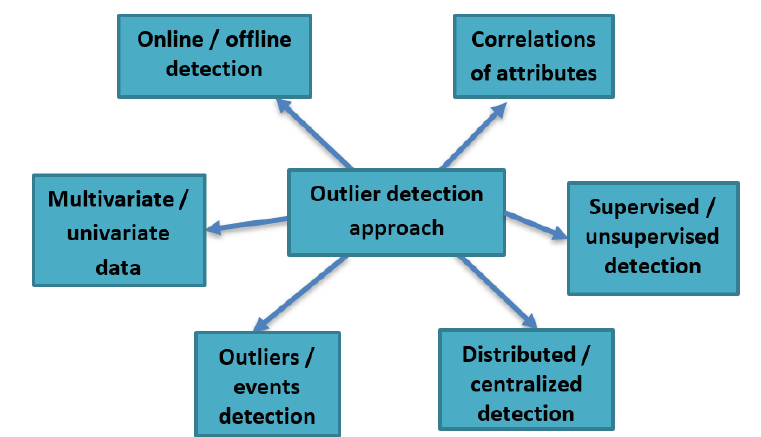
Figure 3. Outlier Detection Approach in